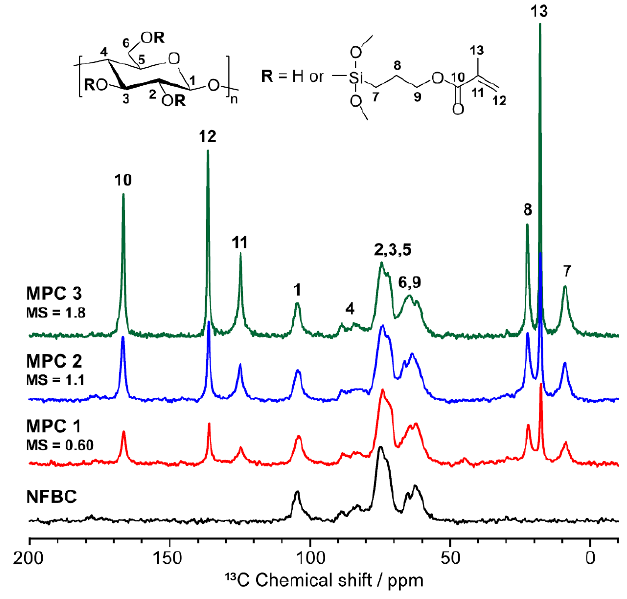
Figure 2. Solid ‐ state 13 C NMR spectra of MPC 1–3 and NFBC. Figure 2. Solid-state 13 C NMR spectra of MPC 1–3 and